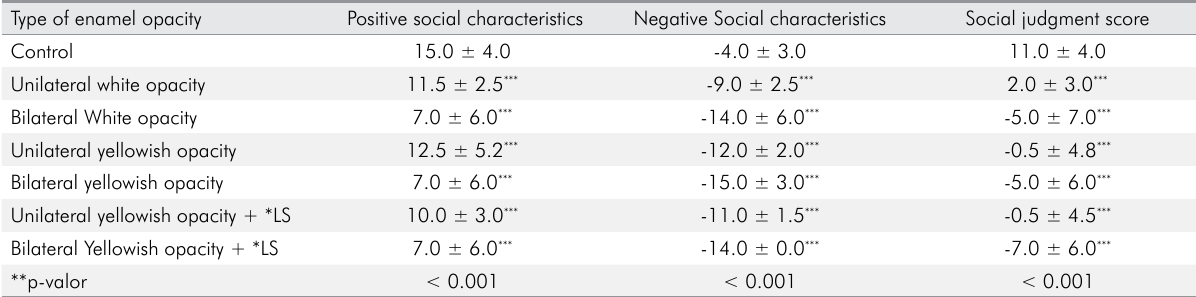
Table 2. Analysis of the Discriminant Construct Validity of the social judgment scale.